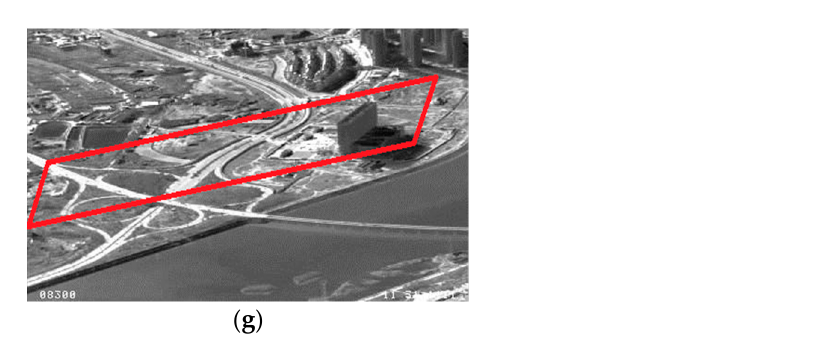
Figure 14. Scene 2 visible light target matching. ( a ) Template; ( b ) real-time graph; ( c ) extract green lines from templates in Scene 2; ( d ) extract red lines from real-time graphs in Scene 2; ( e ) red box position in template in Scene 2; ( f ) red box position in real-time map in Scene 2; ( g ) red box position of SURF in Scene 2. Table 2. Target recognition accuracy.